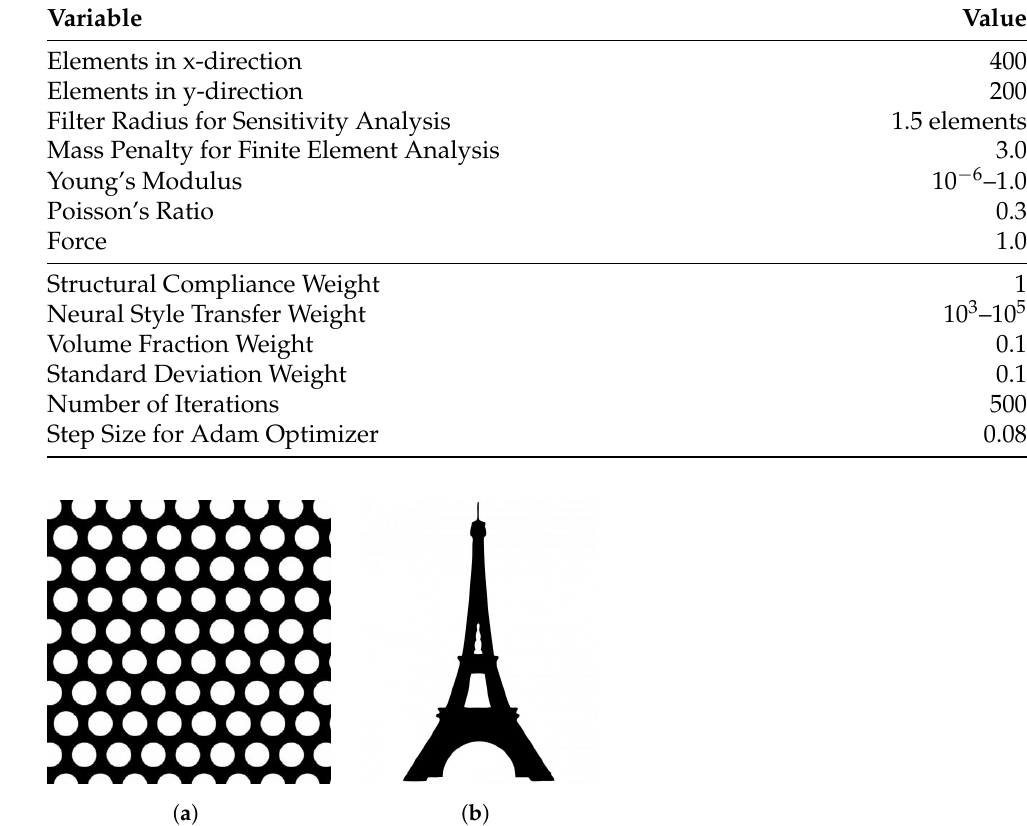
Table 1. Variable Initialization.